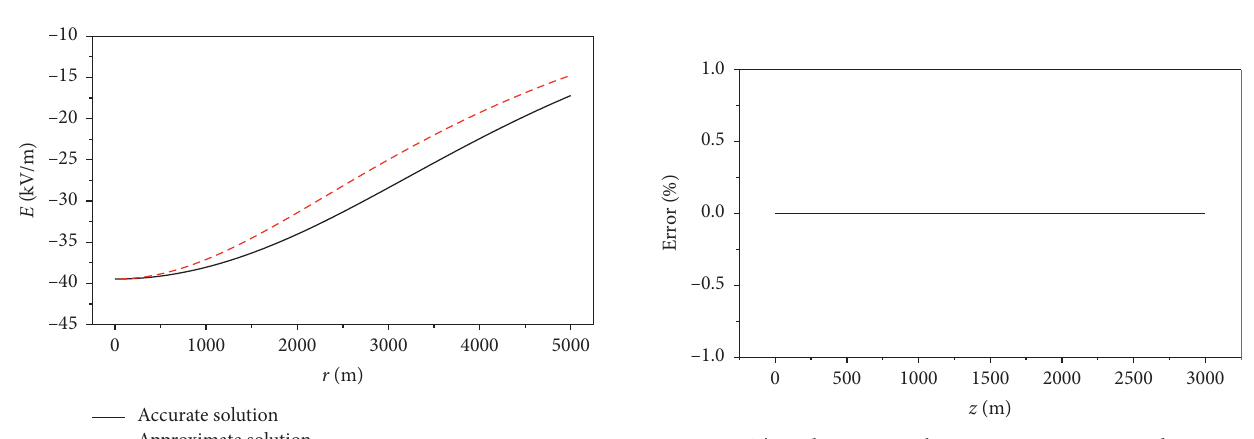
Figure 6: Comparison between approximate and accurate solu- tions while r � 0.